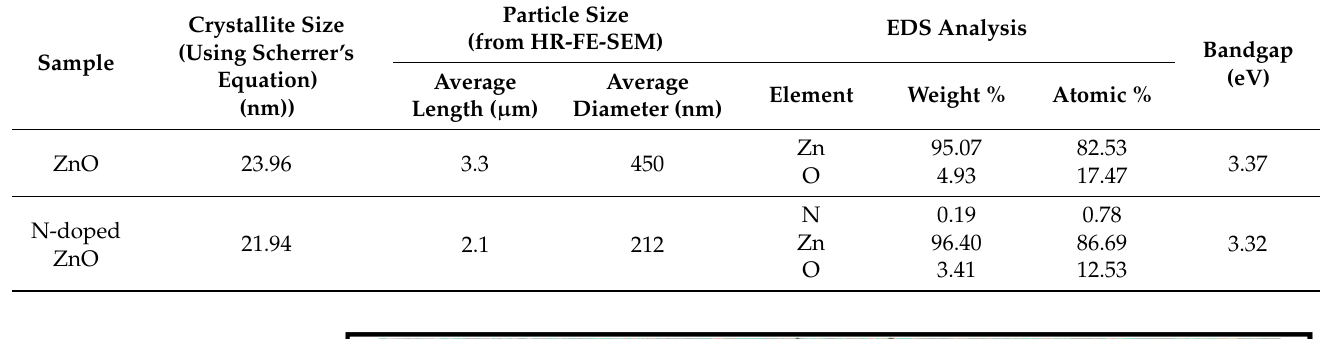
Table 1. Summary of analytical data for ZnO and N-doped ZnO.